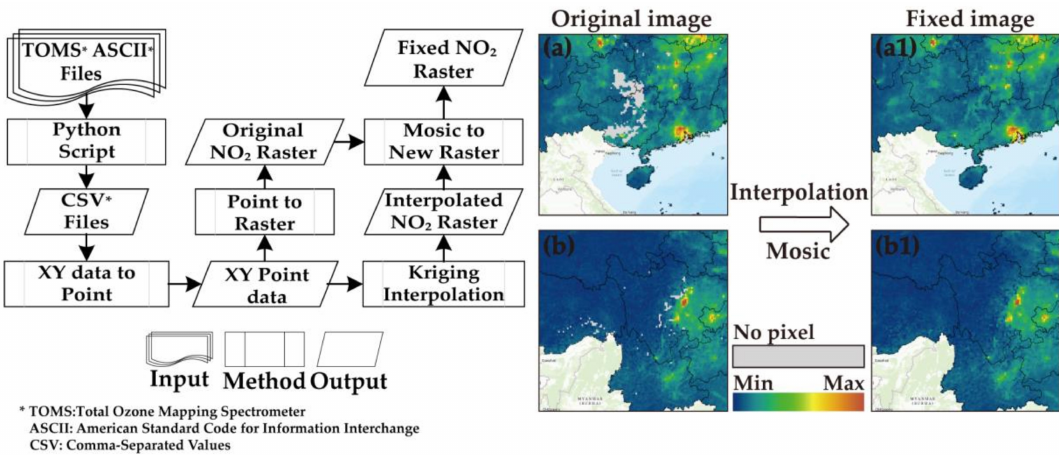
Figure 2. The flowchart of image preprocessing and restoration in pixel-missing areas. Note: ( a ) and ( b ) are the original images from February and September of 2018, respectively; ( a1 ) and ( b1 ) are the images restored using an interpolation